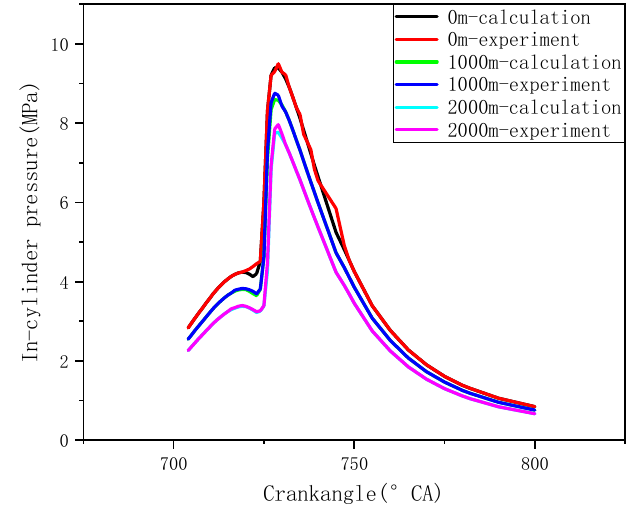
Figure 4. Comparison of cylinder pressure test value and calculated value.